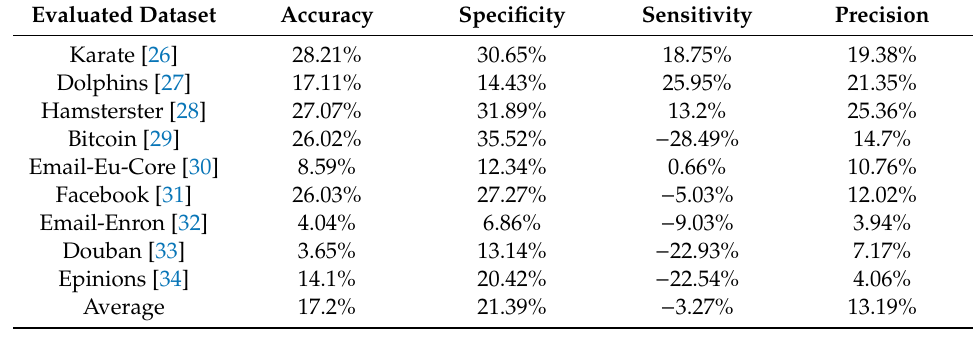
Table 4. Community prediction performance improvement. The comparison of the bagging community prediction performance over the representative subgraph’s community prediction methodology.